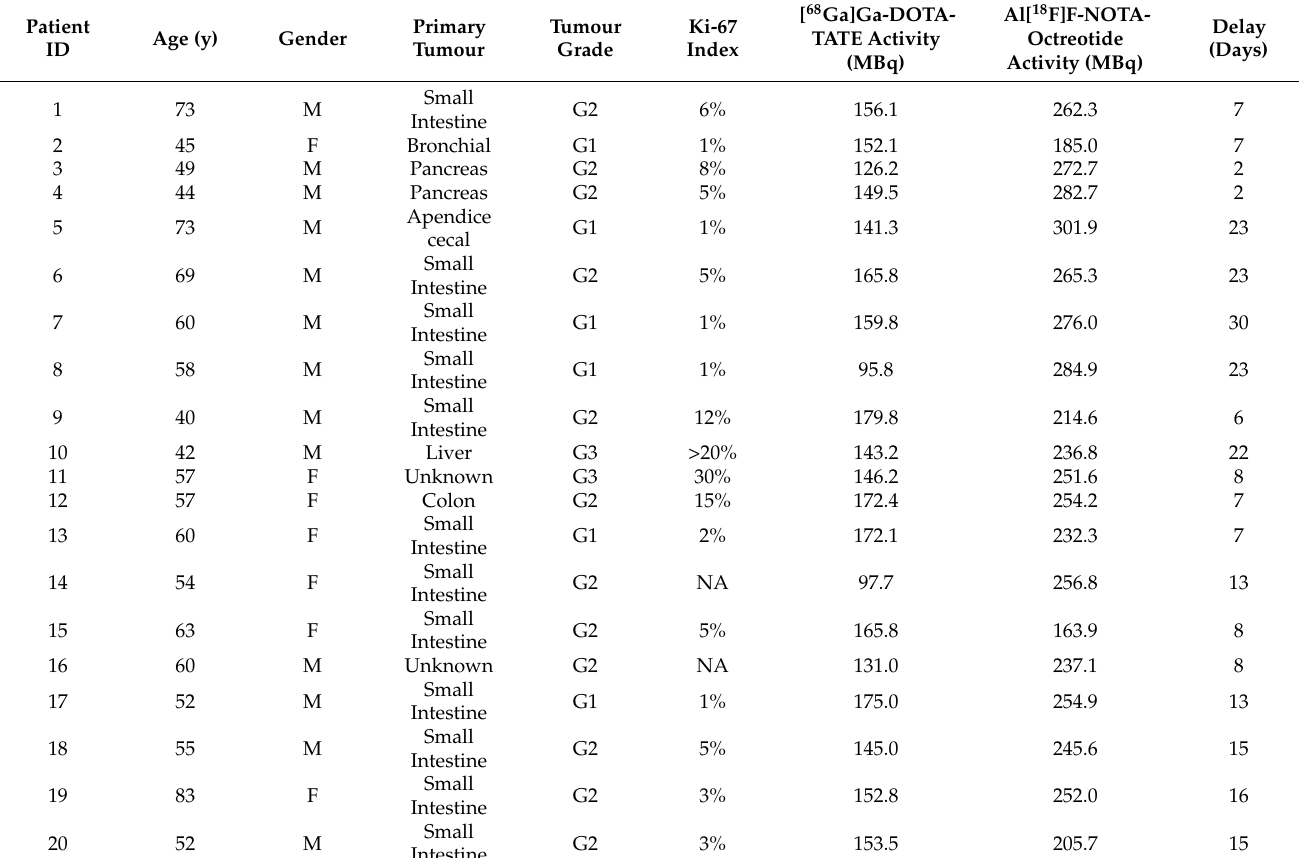
Table 1. Patients’